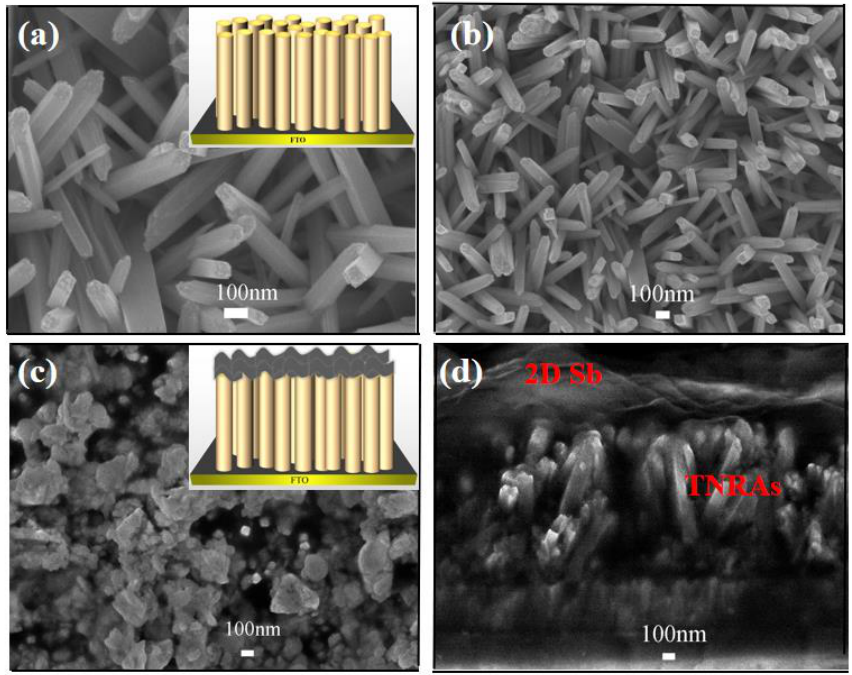
Figure 1. ( a , b ) Top view SEM of TiO 2 NRAs. ( c , d ) SEM images of 2D Sb/TiO 2 NRAs: ( c ) top view, ( d ) cross-sectional view.